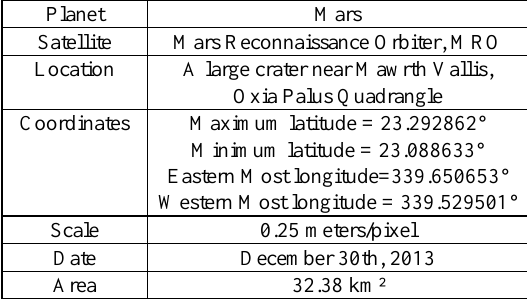
Table 1. Details about the image